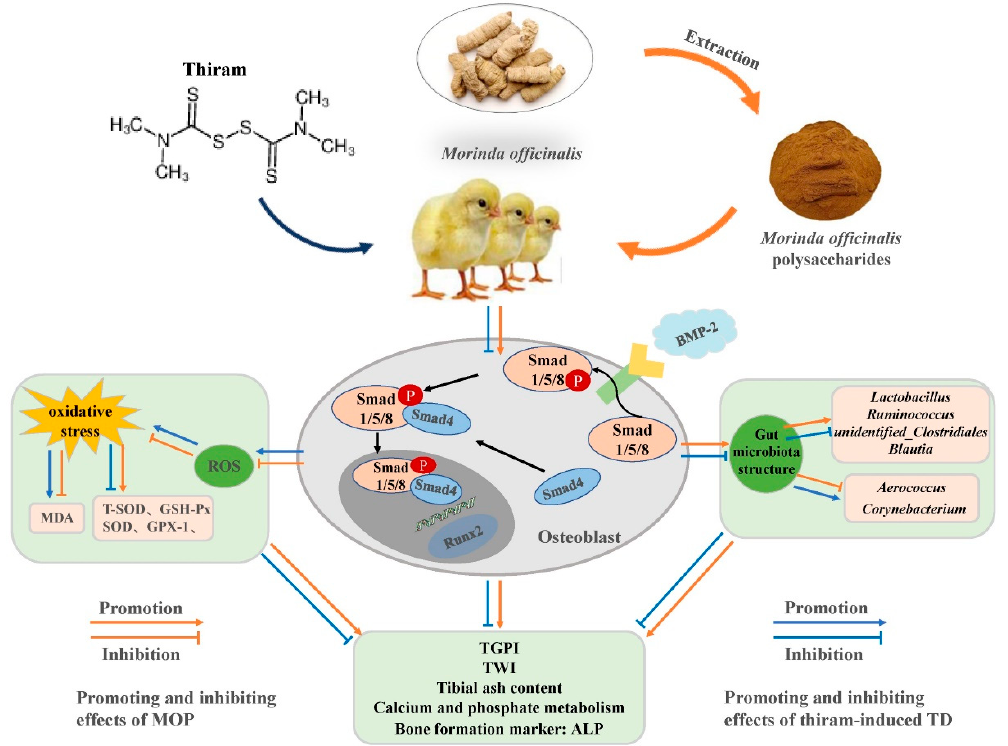
Figure 7. The schematic diagram of the mechanism of MOP in improving TD broilers by regulating the BMP/Smads signaling pathway. ALP, Alkaline phosphatase; BMP-2, Bone morphogenetic protein-2; GSH-Px, Glutathione peroxidase; MDA, Malondialdehyde; Runx2, Runt-related transcription factor-2; ROS, Reactive oxygen species; Smad1,4,5,8, Smad family member 1,4,5,8; TGPI, Tibial growth plate index; T-SOD, Total super-oxide dismutase; TWI, Tibial weight index.